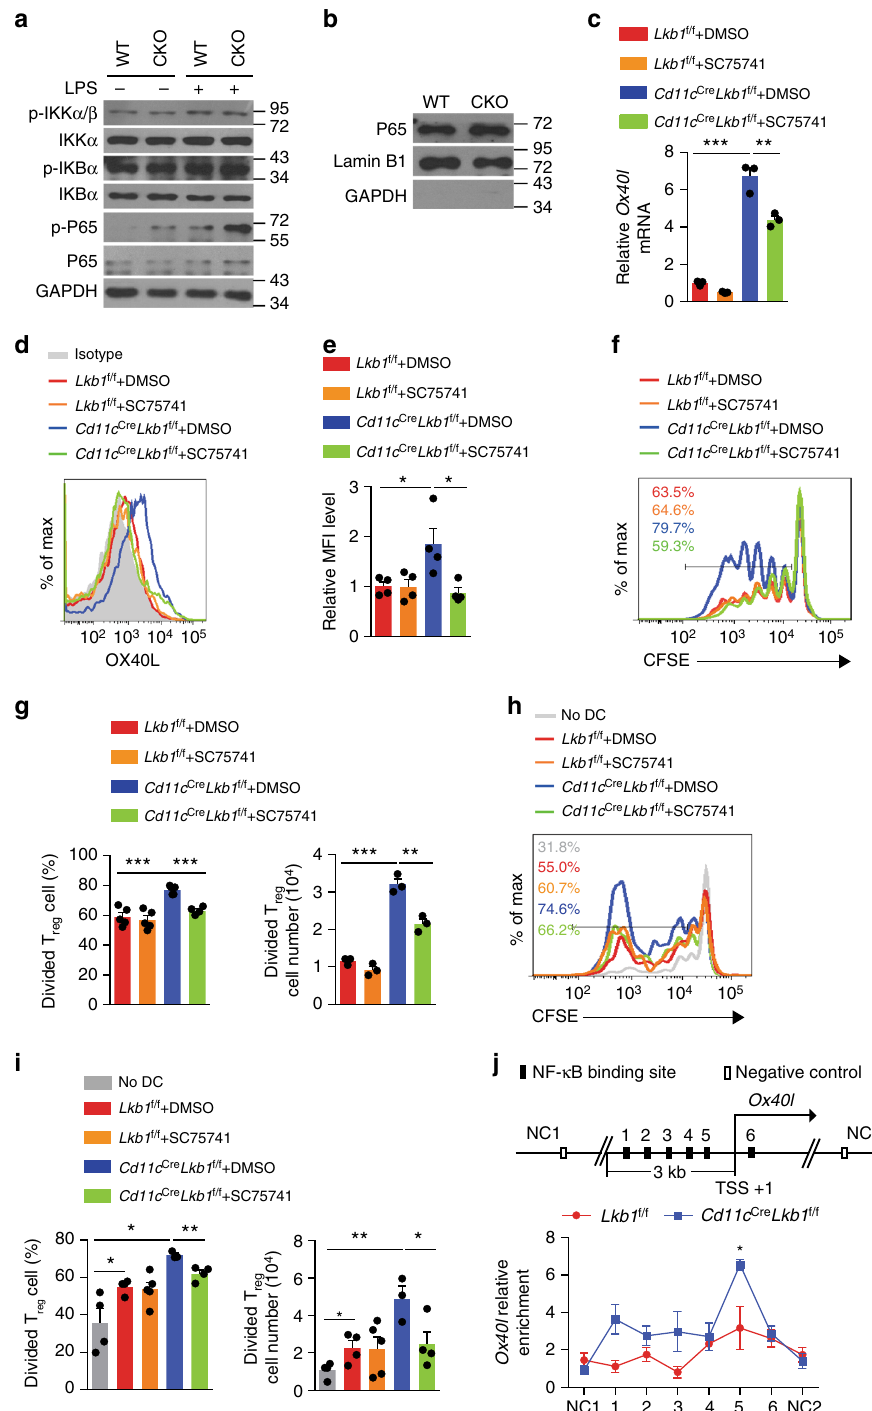
Fig. 5 Lkb1 restrains NF- κ B signalling to inhibit Ox40l expression. a Immunoblot analysis of total and phosphorylated p65, IKK α and I κ B α expression in WT and Lkb1-de fi cient DCs treated or untreated with LPS (1 μ gml − 1 ) for 40 min. b Immunoblot analysis of p65 protein in the nucleus of splenic DCs from Lkb1 f/f and Cd11c Cre Lkb1 f/f mice. c Real-time PCR analysis of the mRNA level of Ox40l in splenic DCs from Lkb1 f/f and Cd11c Cre Lkb1 f/f mice treated with or without an NF- κ B inhibitor (SC75741) for 3 days. d , e Flow cytometric analysis ( d ) and quanti fi cation ( e ) of relative MFI of OX40L expression on DCs in LNs from Lkb1 f/f and Cd11c Cre Lkb1 f/f mice treated or untreated with an NF- κ B inhibitor (SC75741) for 3 days. f , g Flow cytometric analysis ( f ), percentage and number ( g ) of CFSE-labelled T reg cells co-cultured with DCs from Lkb1 f/f and Cd11c Cre Lkb1 f/f mice treated with or without SC75741 for 4 days. h , i Flow cytometric analysis ( h ), percentage and number ( i ) of CFSE-labelled T reg cells (CD4 + Foxp3 + , 2×10 6 ) sorted from B6 mice transferred together with or without DCs (1×10 6 ) sorted from Lkb1 f/f or Cd11c Cre Lkb1 f/f mice treated with or without SC75741 into irradiated NSG mice via tail vein injection for 3 days. j Relative enrichment of NF- κ B p65 to Ox40l promoter in Lkb1 f/f or Cd11c Cre Lkb1 f/f DCs treated with LPS (1 μ g ml − 1 ) for 3 h, determined by ChIP. The results are presented as the mean ± S.E.M., * P < 0.05, ** P < 0.01, *** P < 0.001, by Student's t -test ( c , e , g , i ). Data are pooled from e , g , i , j or are representative of at least three a , b , d , f , h independent experiment with similar